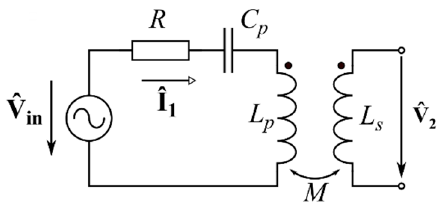
Figure 12. Faraday’s law method for measurement setup.